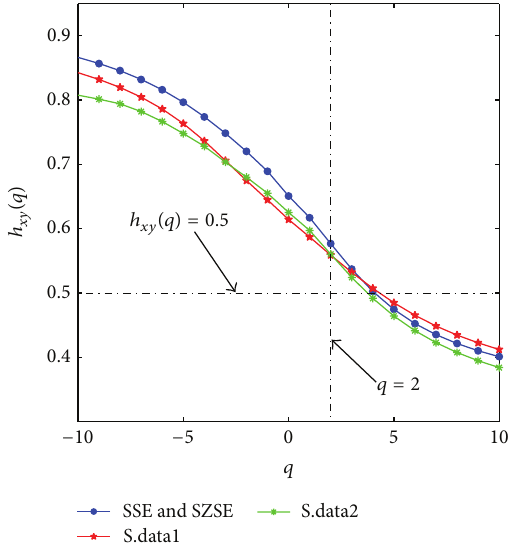
Figure 5: Cross-correlation exponent ℎ(𝑞) of return series for the real markets and the financial model.